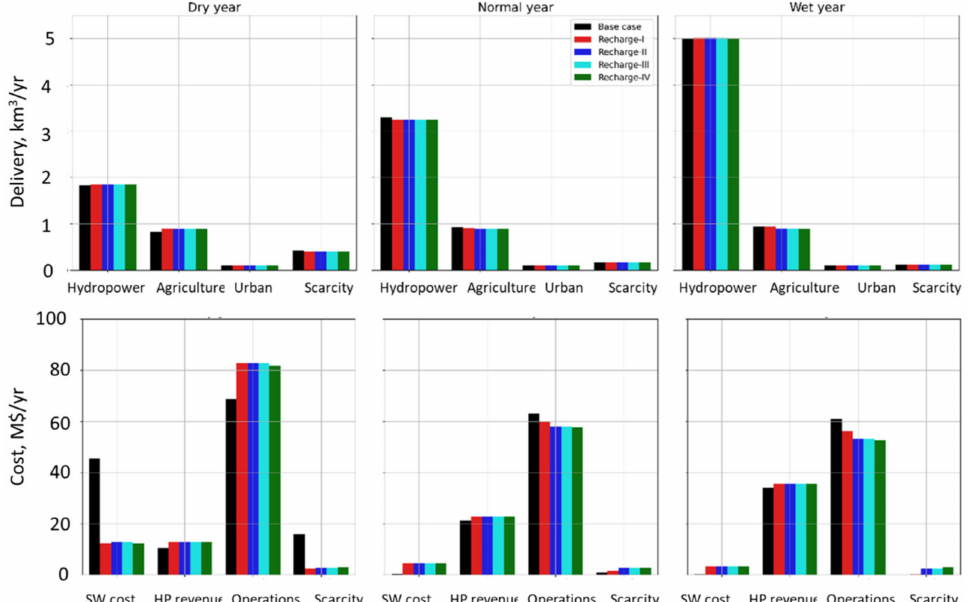
Figure 8. Major water supply ( top ) and cost ( bottom ) portfolio in the Lower American River in different water